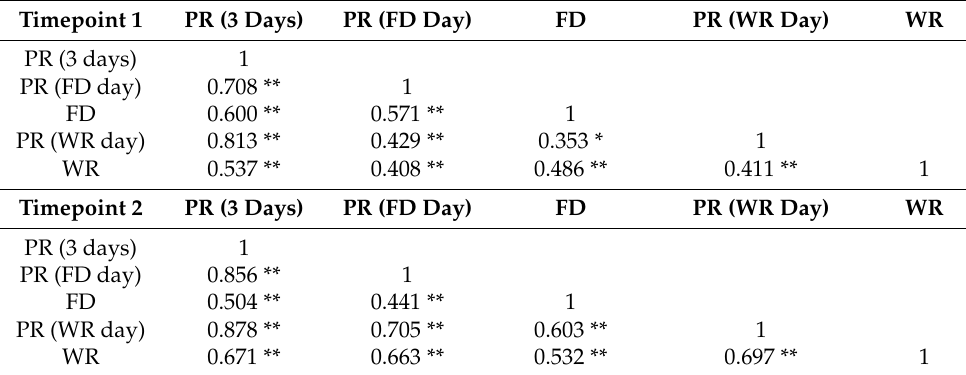
Table 8. Spearman’s correlation coefficients between